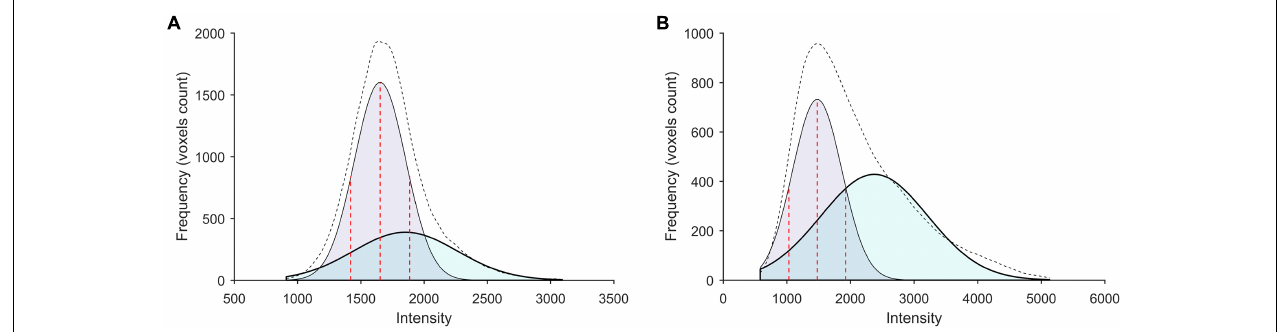
FIGURE 2 | Subject-specific WM histograms for two typical subjects evaluated by [ 18 F]-APN-1607 PET. (A) A 56-year-old HC (male). (B) A 56-year-old AD patient (female). Purple and cyan areas represent lower- and higher-intensity signals, respectively; the black dotted line shows the sum of two peaks (bimodal Gaussian distribution). For AD patients, voxels that spilled into the WM were captured by the higher peak.